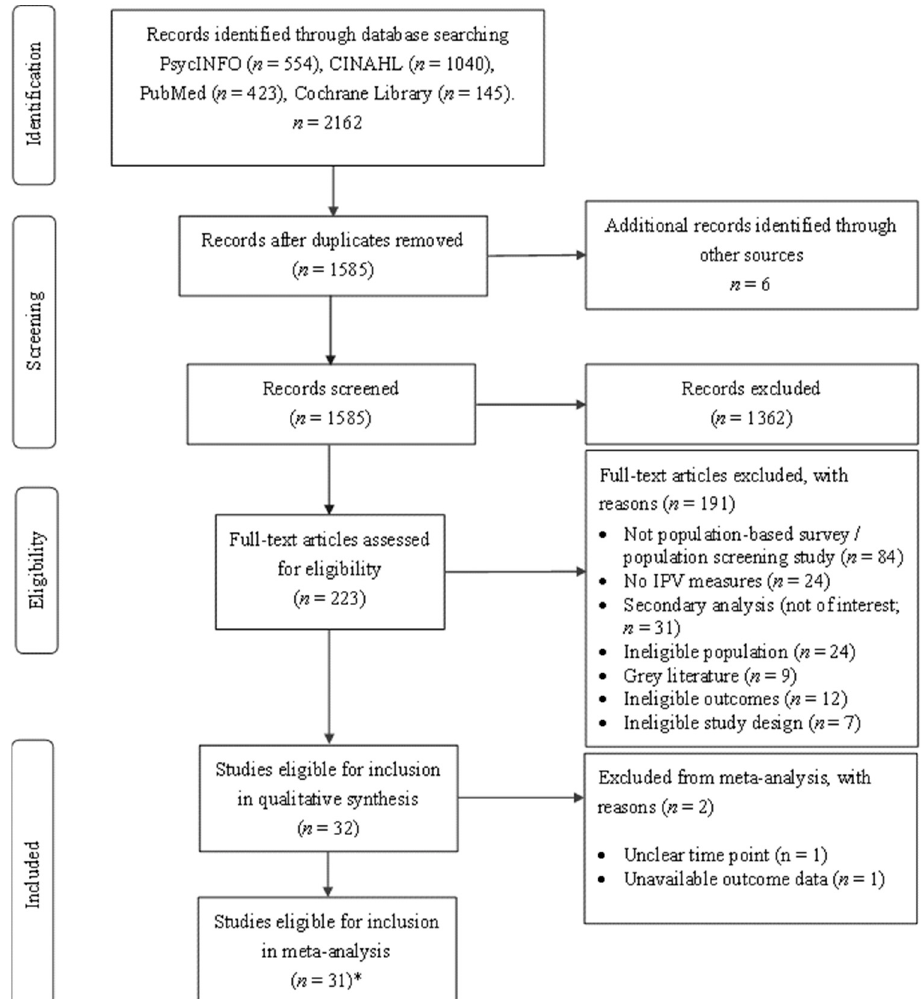
Figure 1. PRISMA flow diagram. Note: * = One paper included two studies